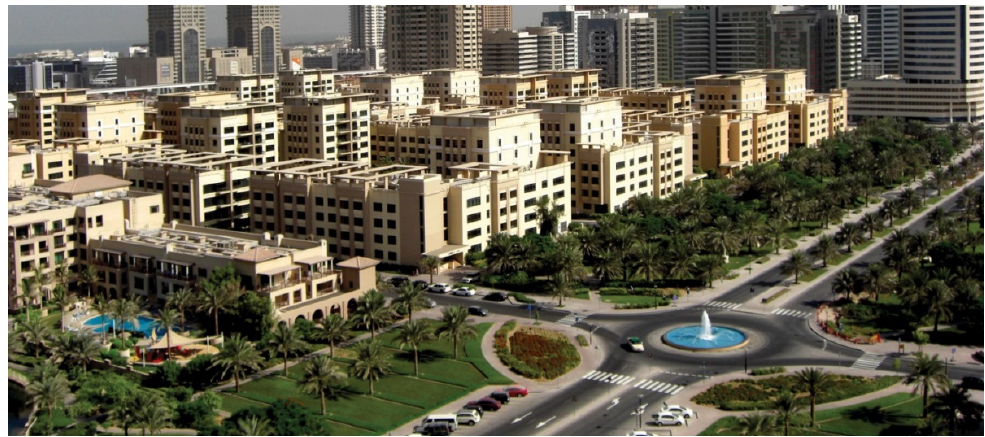
Figure 2. The Greens Project in Dubai, United Arab Emirates. Sick Building Syndrome (SBS), mostly caused by formaldehyde (CH 2 O) and volatile organic compounds (VOCs) from building materials, has been one of the serious research topics only in the past 10 years [40,41]. SBS symptoms are eye, nose, and throat irritation, headaches, lethargy, difficulty concentrating, and sometimes dizziness, nausea, and chest tightness [42,43]. Table 1 shows the effects of each hazardous substance on the human body [44]. Table 1. The effects of hazardous substances on the human body.